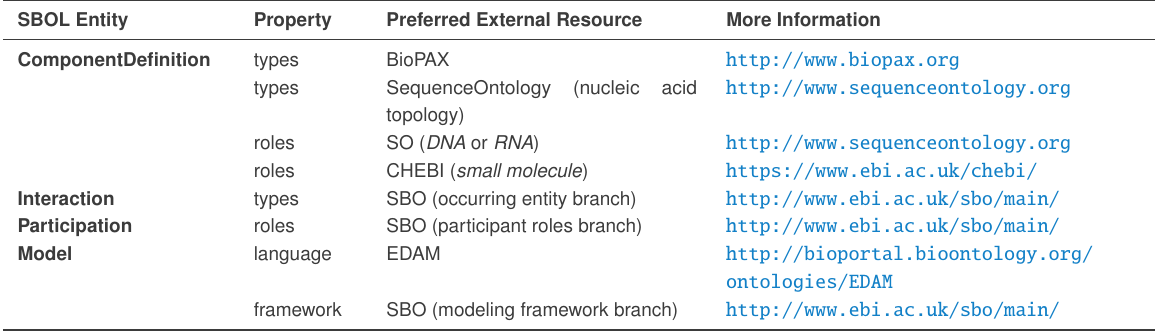
Table 15: Preferred external resources from which to draw values for various SBOL